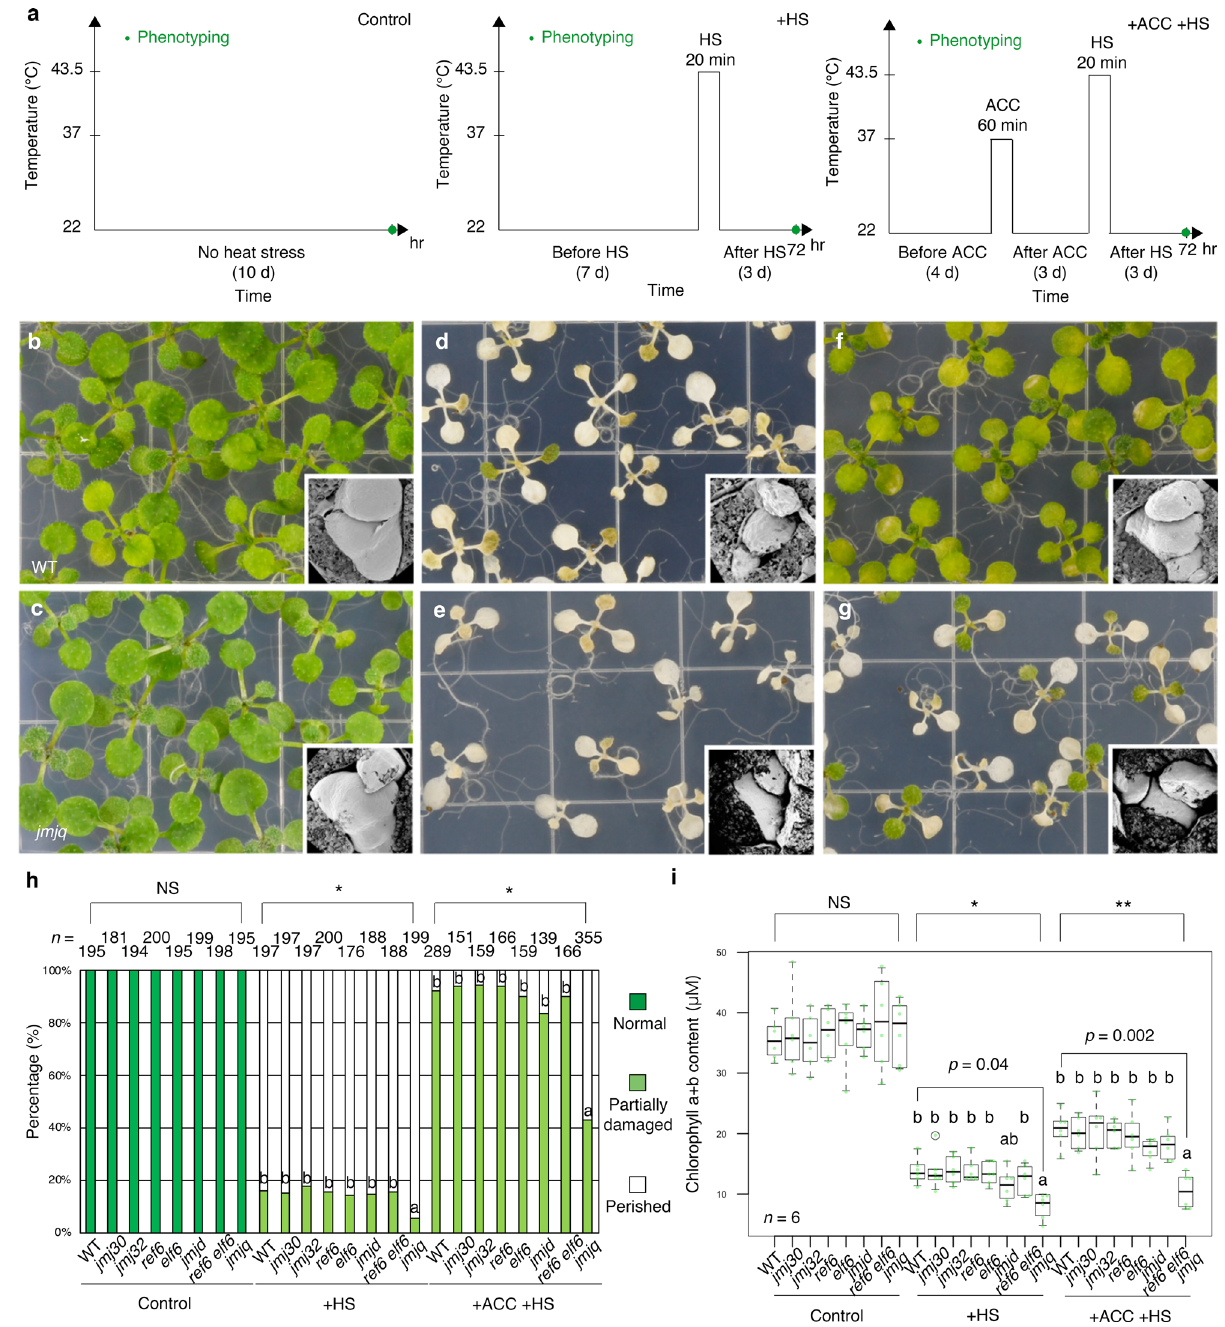
Fig. 1 H3K27me3 demethylase activity is required for acquired thermotolerance. a Schematic representation of the temperature conditions used in this study. The time of phenotyping is indicated with a green dot. Left, normal plant growth conditions. Center, basal thermotolerance conditions ( + HS). Right, heat-stress memory conditions ( + ACC + HS). b , c Wild type ( b ) and jmj30 jmj32 ref6 elf6 quadruple mutants ( jmjq ) ( c ) grown under control conditions. d , e Wild type ( d ) and jmjq ( e ) grown under + HS conditions. f , g Wild type ( f ) and jmjq ( g ) grown under + ACC + HS conditions. Insets show scanning electron microscope images of representative shoot apical meristems. h Quanti fi cation of survival rate. In all, 10-day-old seedlings grown under the three different temperature conditions were categorized into three groups based on phenotypic severity: green, normal growth; light green, partially damaged; and white, perished. Different letters indicate signi fi cant differences. Signi fi cance was determined by the χ 2 test followed by a post-hoc test. n > 138. i Quanti fi cation of chlorophyll contents. Sample minimum (lower bar); lower quartile (box); median (middle line); upper quartile (box); and sample maximum (upper bar). Light green dots and white circles represent the chlorophyll contents of individual samples and statistical outliers, respectively. One-way ANOVA test, * p < 1.0 × 10 – 3 ; ** p < 1.0 × 10 – 4 . Different letters indicate signi fi cant differences based on post-hoc Tukey ’ s HSD test. p -values based on post-hoc Tukey ’ s HSD test between wild type and jmjq mutants are shown. p < 0.05. NS nonsigni fi cant. n = 6.